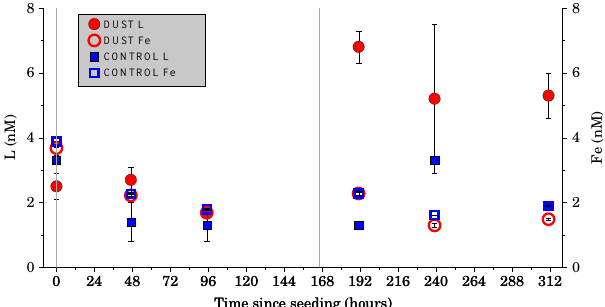
Fig. 3. Evolution of the arithmetical means of the iron binding lig- and (L) concentrations (nmolL − 1 ) of the dust seeded mesocosms (red circles) and the control mesocosms (blue squares) at 5m depth with time since the seeding. The evolution of the arithmetical means of the dissolved iron (Fe) concentrations (nmolL − 1 ) of the dust seeded mesocosms (red empty circles) and the control mesocosms (blue empty squares) at 5m depth with time since the